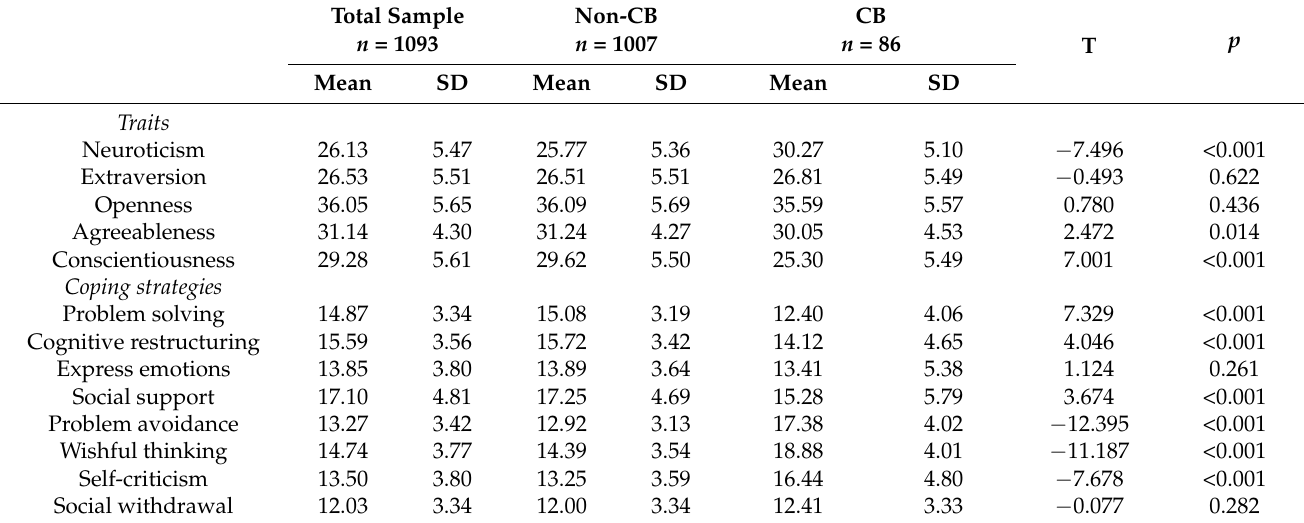
Table 2. Comparison among Non-CB and CB as for traits and coping strategies.